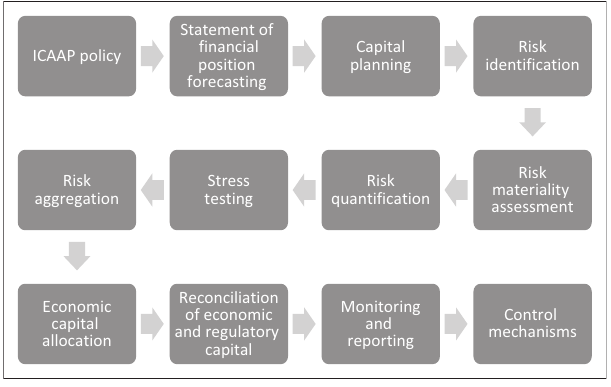
FIGURE 14: Proposed procedure for the implementation of an internal capital adequacy assessment